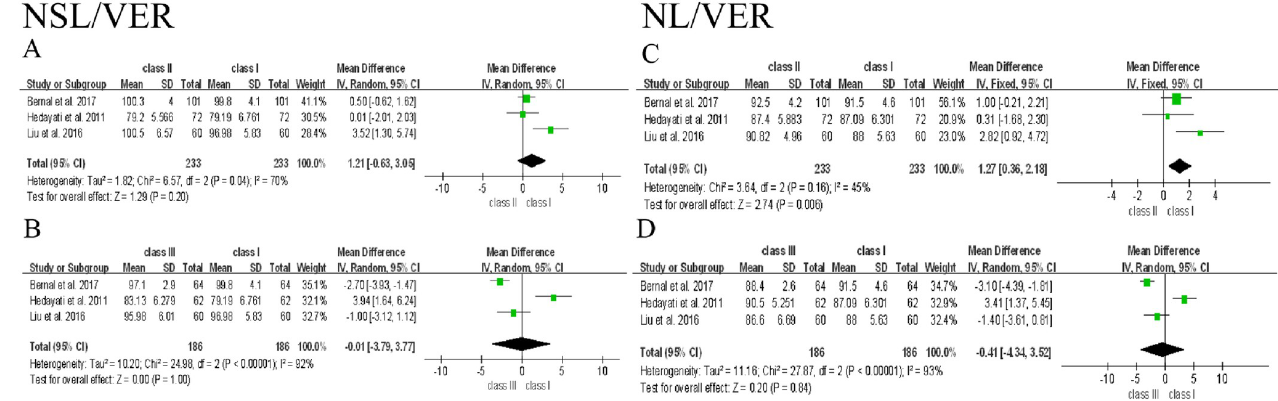
Fig 4. Forest plot of the association between head posture and Class I, II, and III malocclusion.